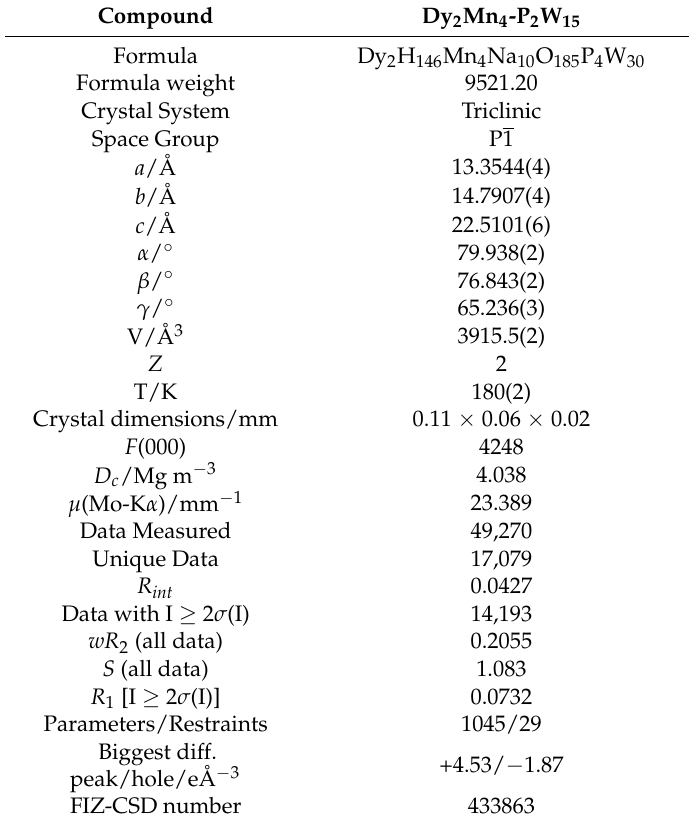
Table 1. Crystal